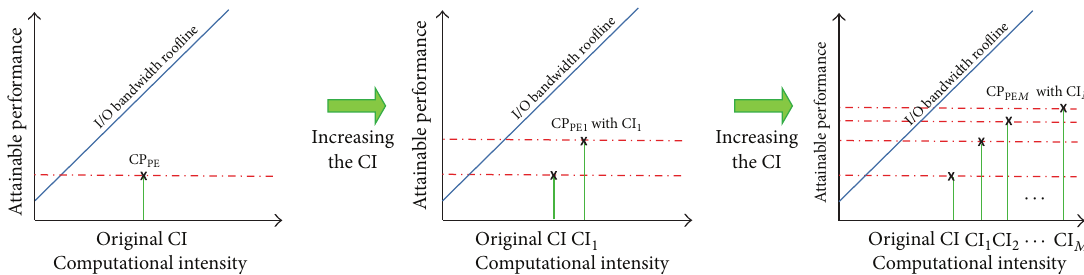
Figure 3: Impact of the increment of the CI in the extended model. By increasing the CI, thanks to the HLS optimizations, for example, the performance of one PE increases as well.